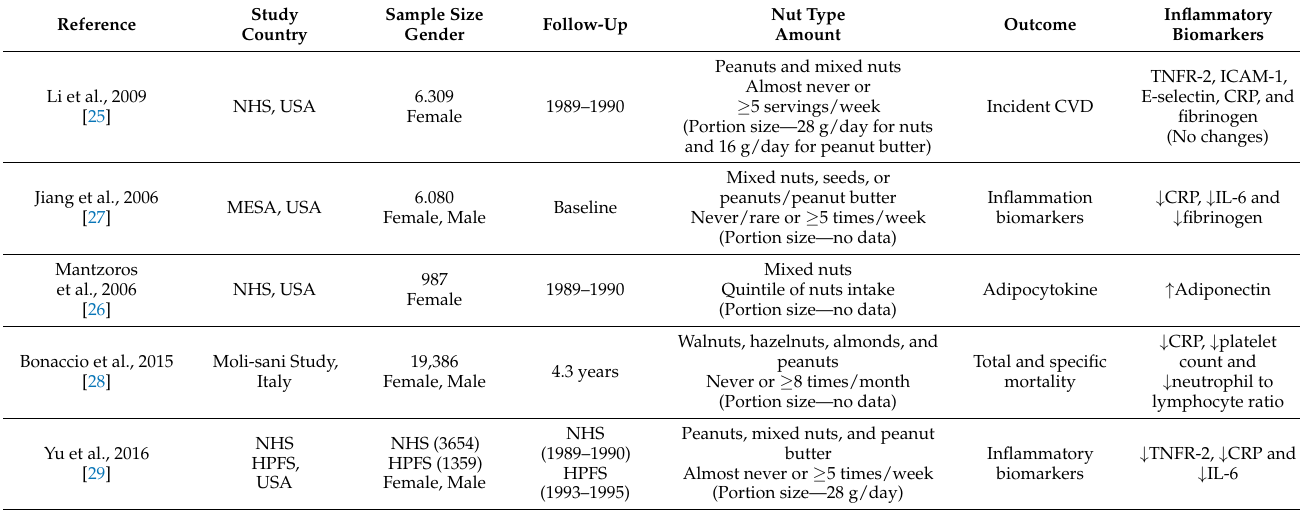
Table 1. Cohort Studies: Associations between nuts and inflammatory